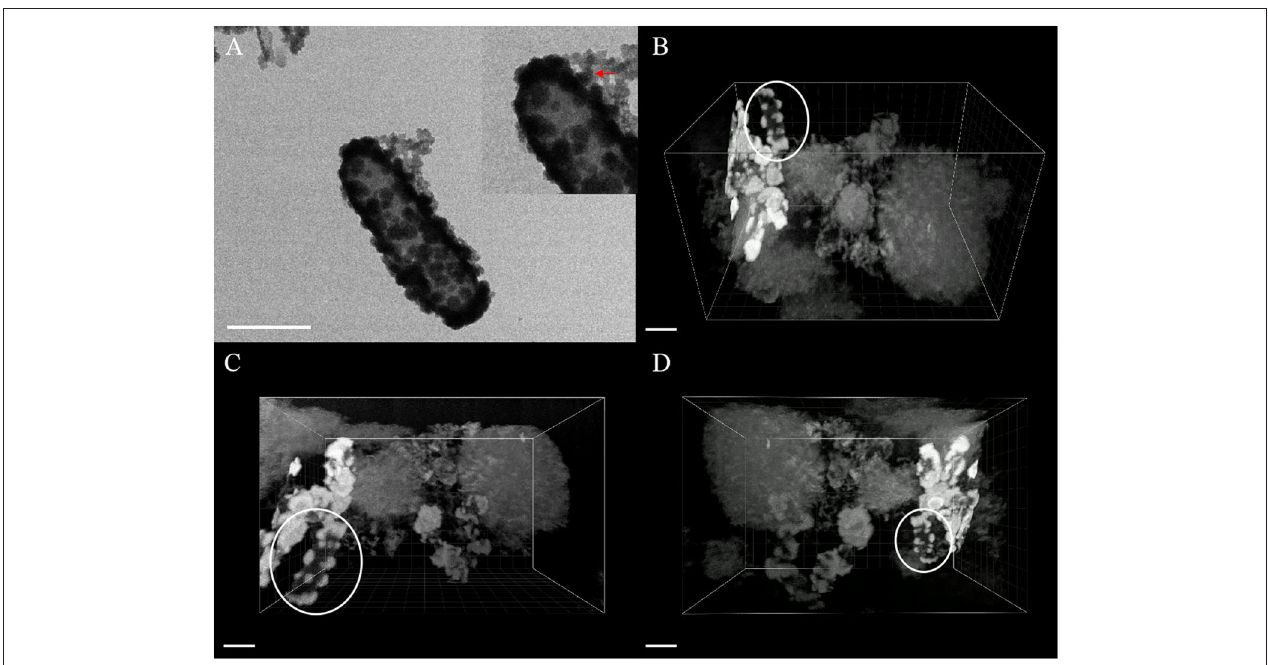
FIGURE 8 | TEM image (A) and FIB/SEM serial images (B–D) of mineral globules [red arrow of inset in (A) , white circle in (B–D) ] spread on cell surface, scale bar = 1 µ